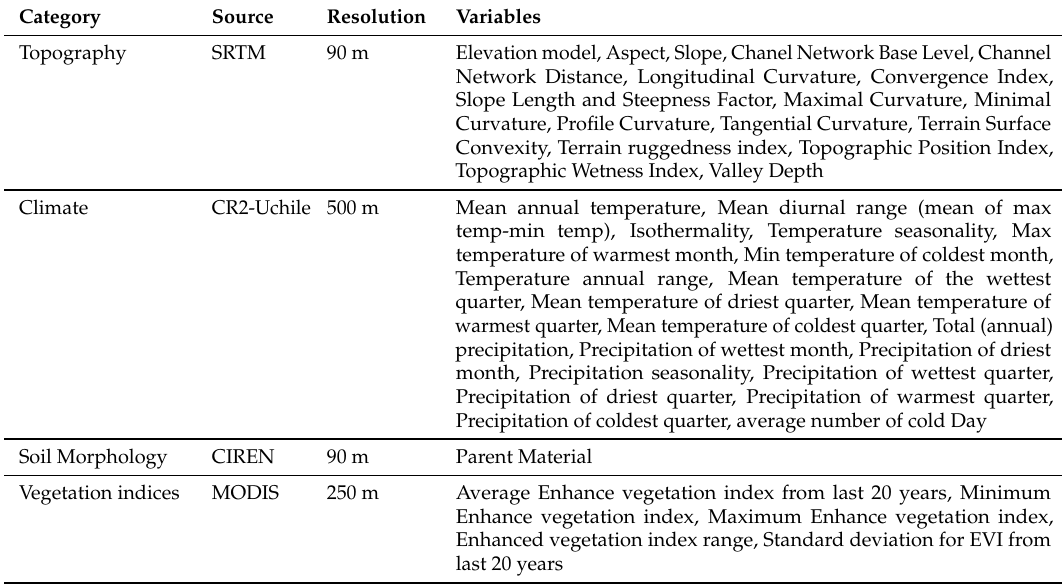
Table A1. Enviromental covariates used to model soil organic carbon and forest floor carbon using digital soil mapping